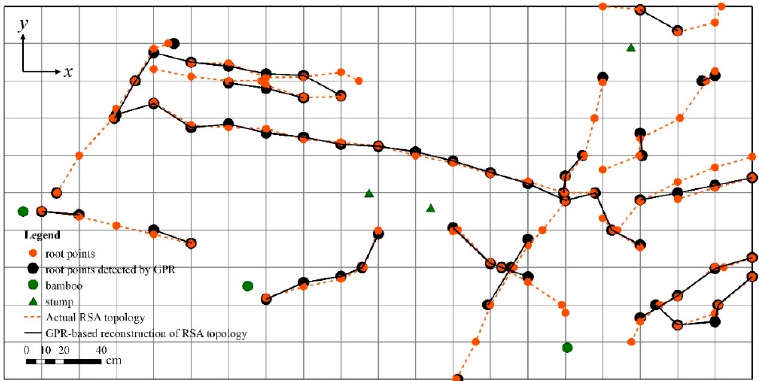
Figure 12. Comparison of actual measured (red dotted lines) and reconstructed (black solid lines) topology of the rhizome system. The measured root system architecture (RSA) topology was ob- tained by directly connecting the measured root points (red circles), while the ground-penetrating radar (GPR)-based RSA topology was constructed by connecting the root points detected by GPR (black circles).